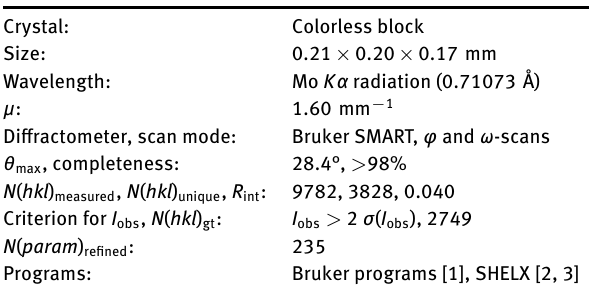
Table 1: Data collection and